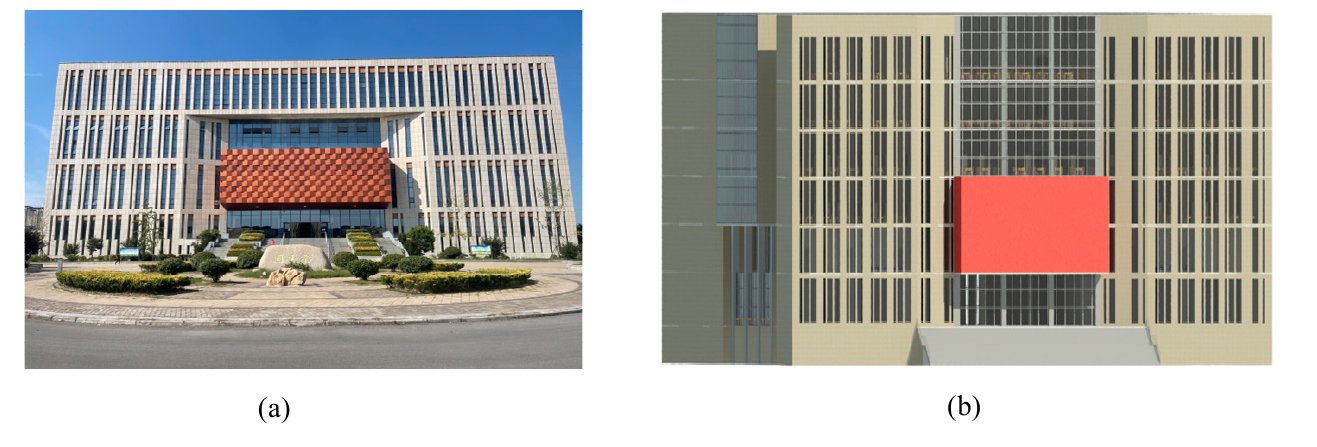
Figure 1. University library. ( a ) Front view of library. ( b ) Building Information Model. Table 1. Library evacuation channel